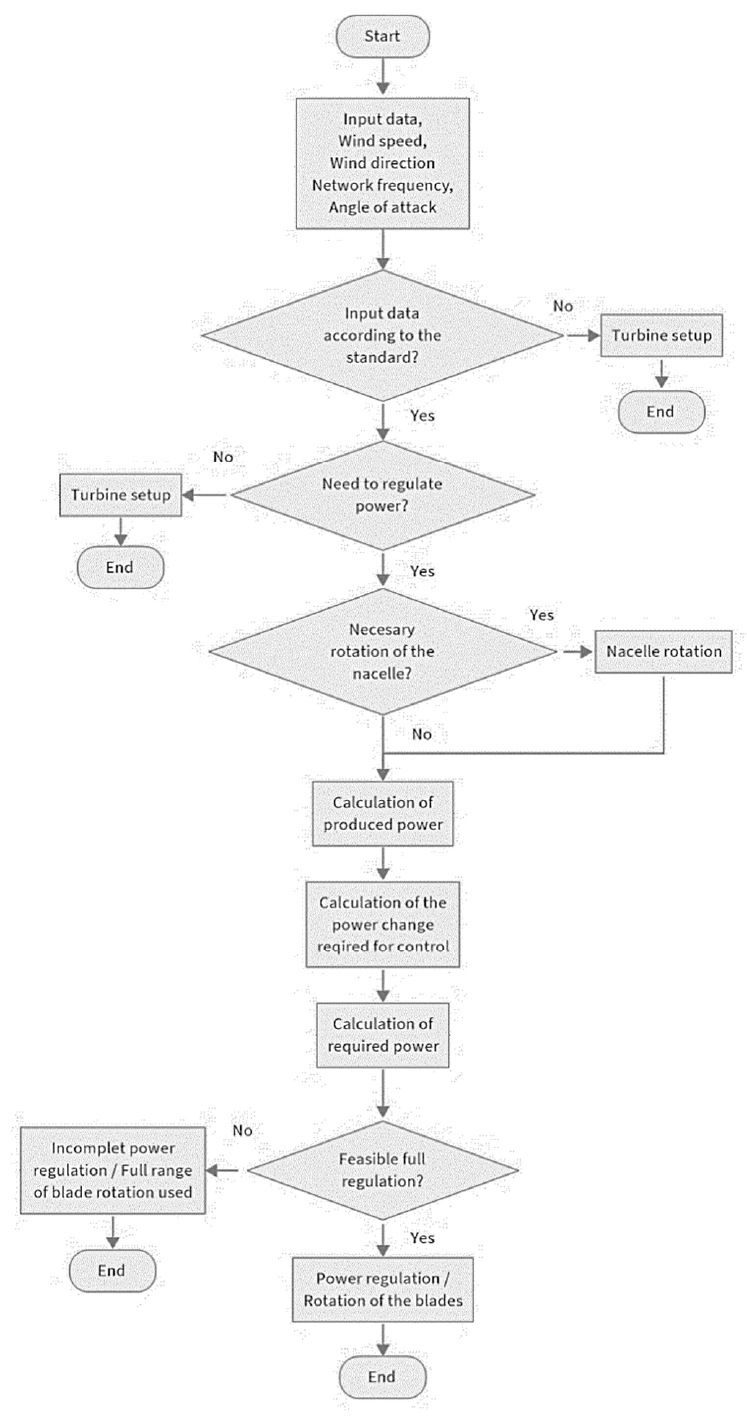
Figure 7. Flow chart of wind power output regulation [source: author’s archive] .